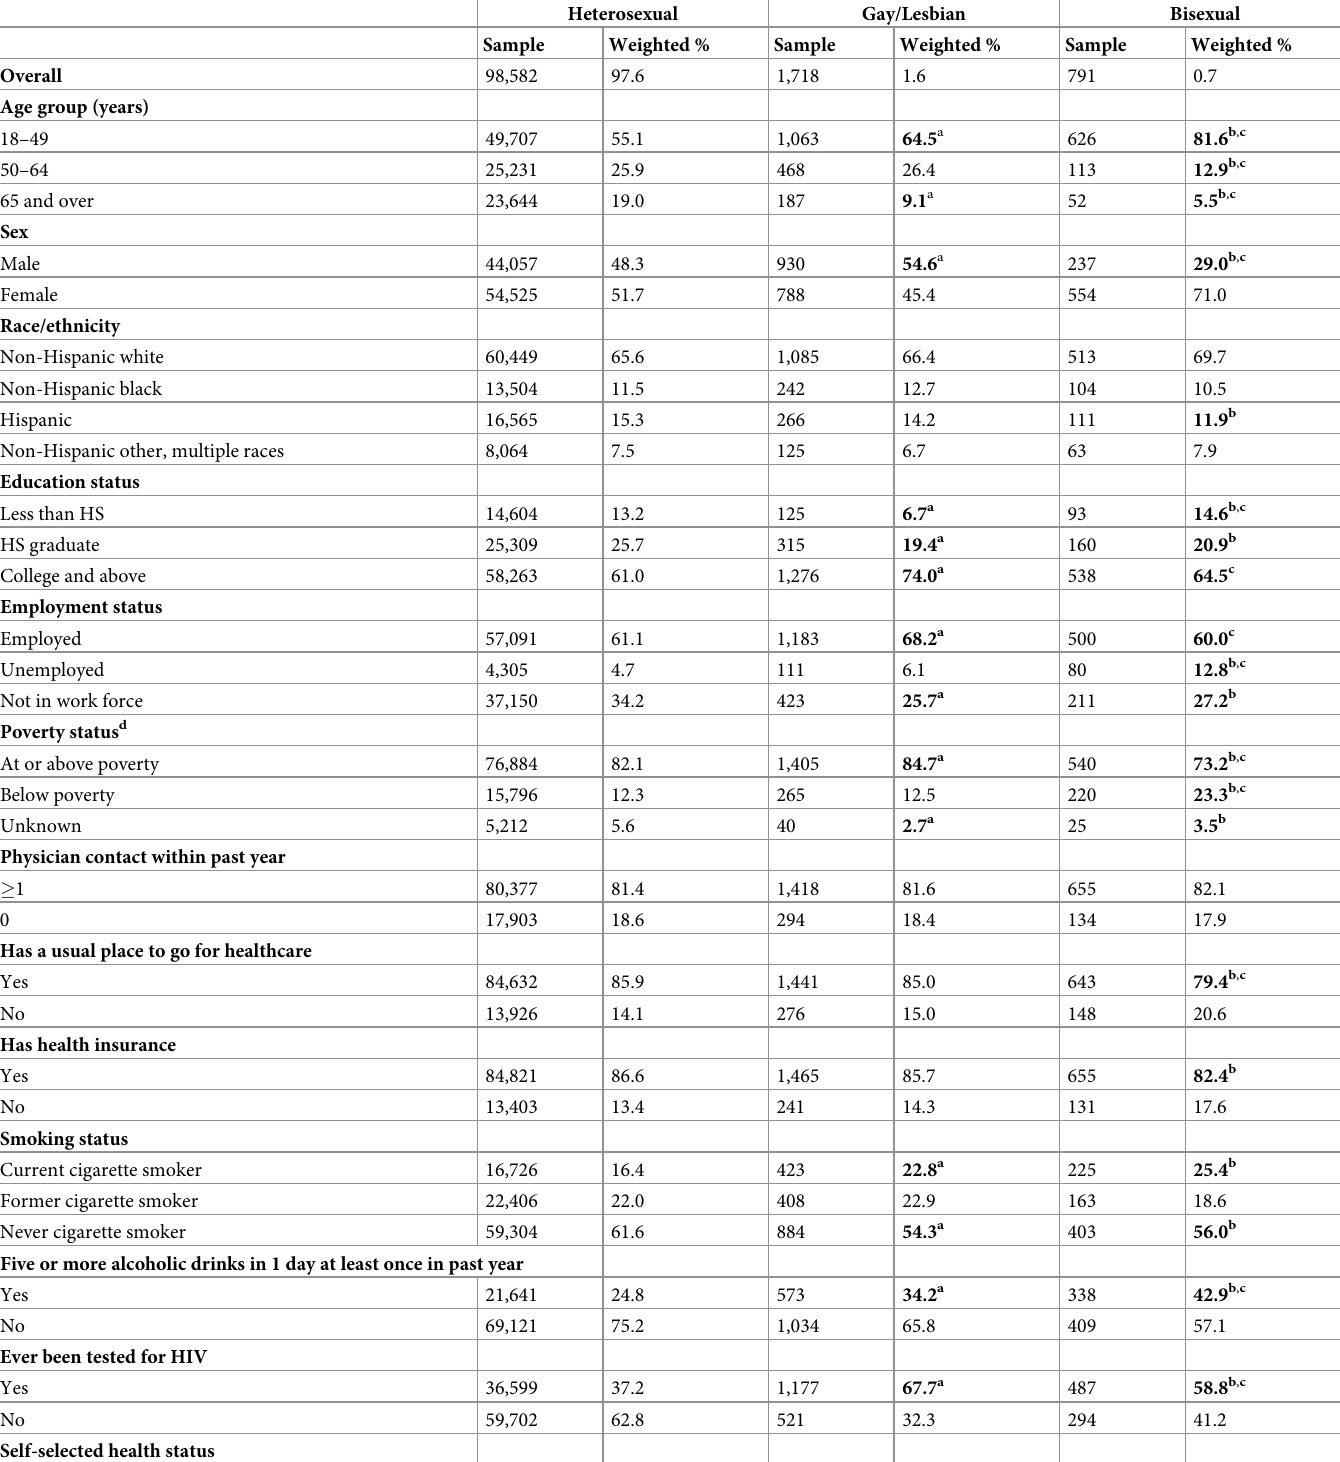
Heterosexual Gay/Lesbian Bisexual Sample Weighted % Sample Weighted % Sample Weighted %